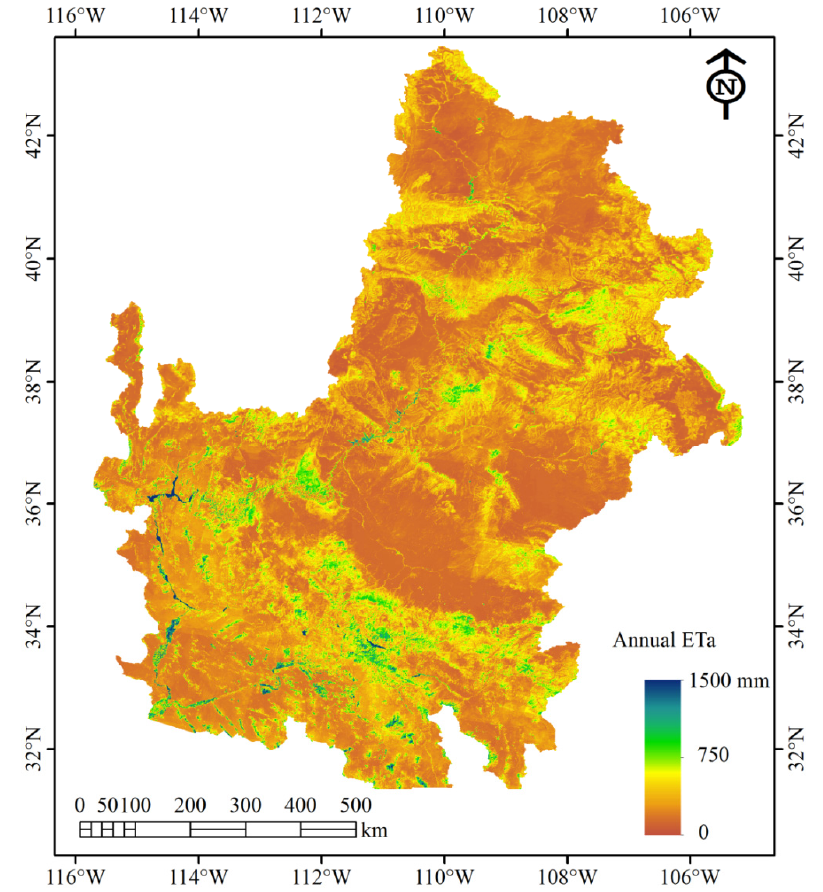
Figure 4. Spatial distribution of evapotranspiration in the Colorado River Basin for 2010 using Landsat